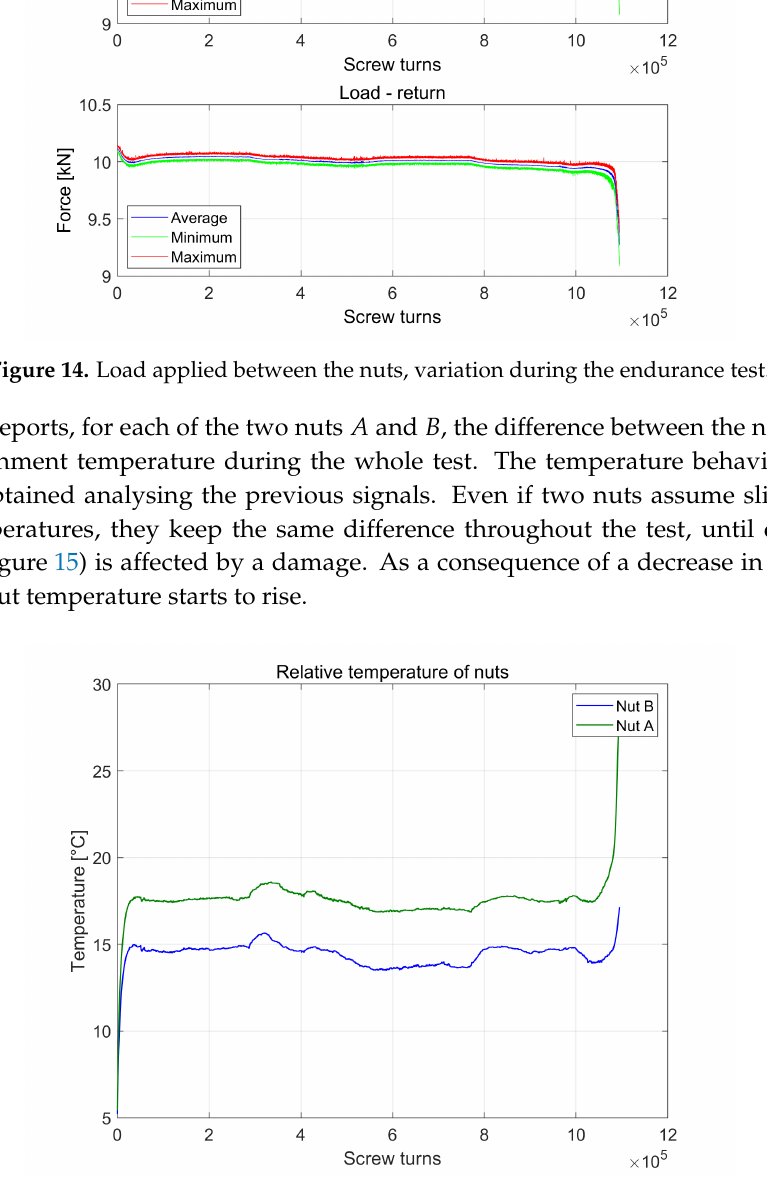
Figure 15. Relative